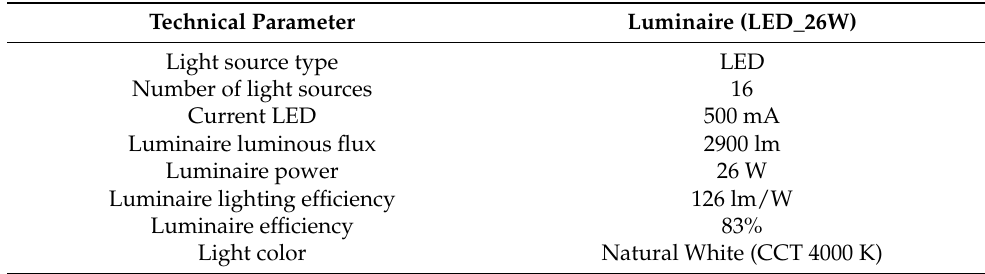
Table 2. Technical parameters of LED_26W